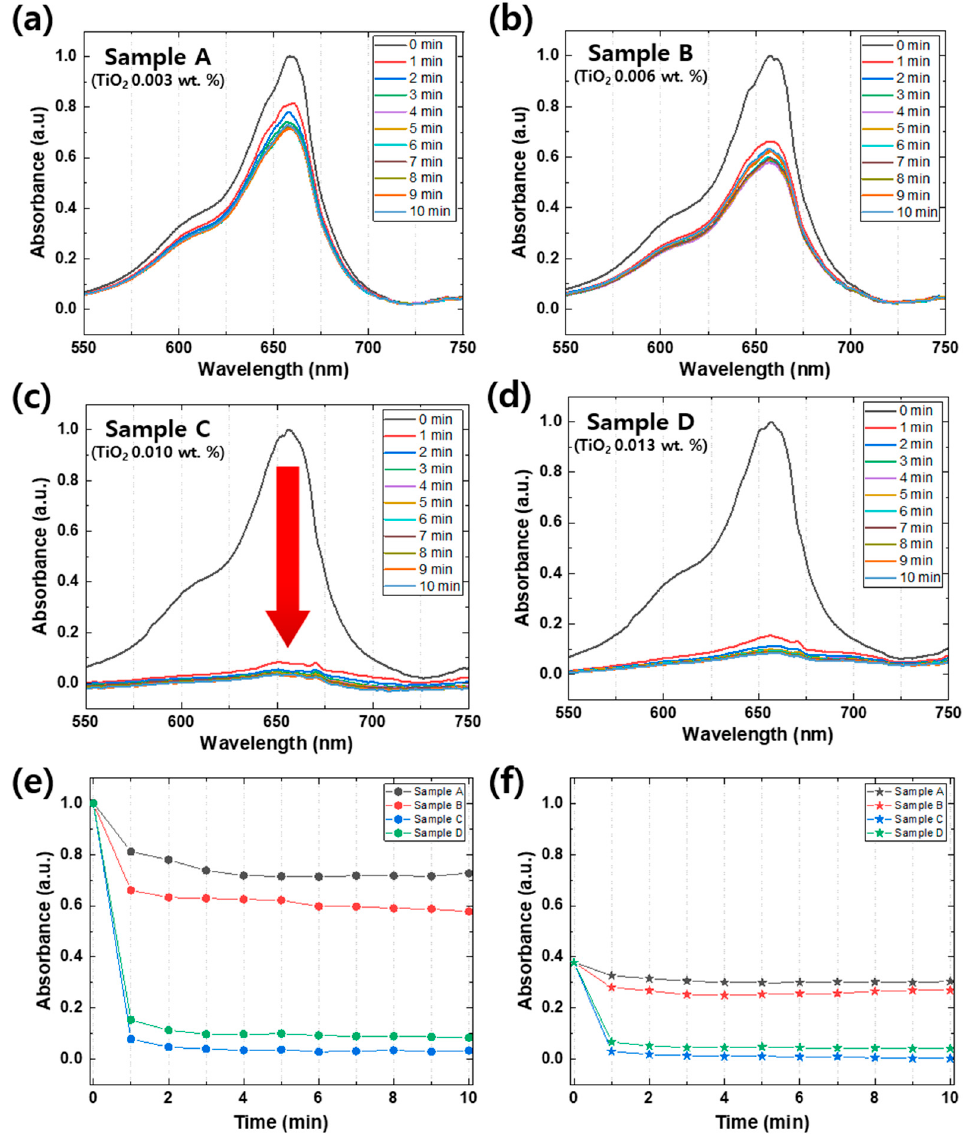
Figure 5. ( a – d ) Absorbance spectra of 4 different MB samples (Samples A to D) with TiO 2 nanoparticle concentration, which is described in Table 1. The arrow in ( c ) indicates rapid photodegradation occurring within 1 min, from 0 min to 1 min. Changes in the absorption of 662 nm ( e ), which is the peak with methylene blue characteristics, and 603 nm ( f ), which is the shoulder at intervals of 1 min per 10 min of 4 different samples. The black lines, the red lines, the blue lines, and the green lines are Samples A, B, C, and D, respectively.